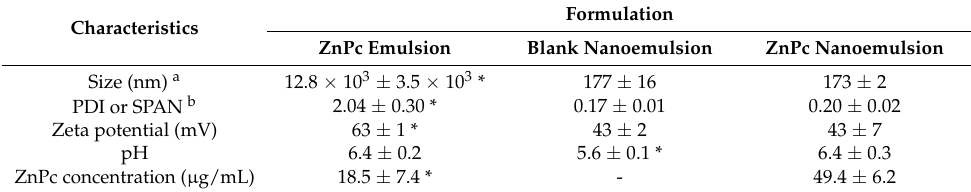
Table 1. Physicochemical characterization of the formulations and concentration of solubilized ZnPc.